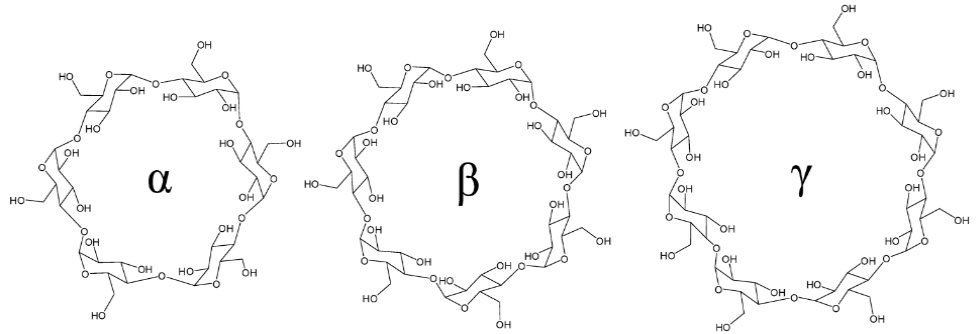
Figure 1. Structure of three parent cyclodextrin. (Adapted with permission from Ref. [14]. Copyright © 2009 American Chemical Society).